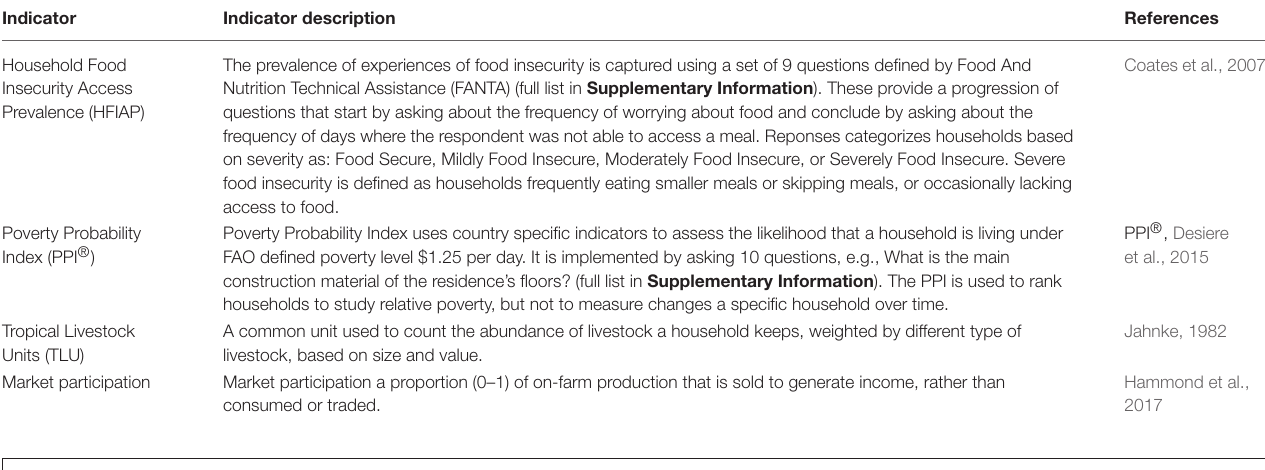
TABLE 1 | Food Security and Socioeconomic indicators calculated using RHoMIS methods from survey data, adapted from full method description in Hammond et al. (2017).